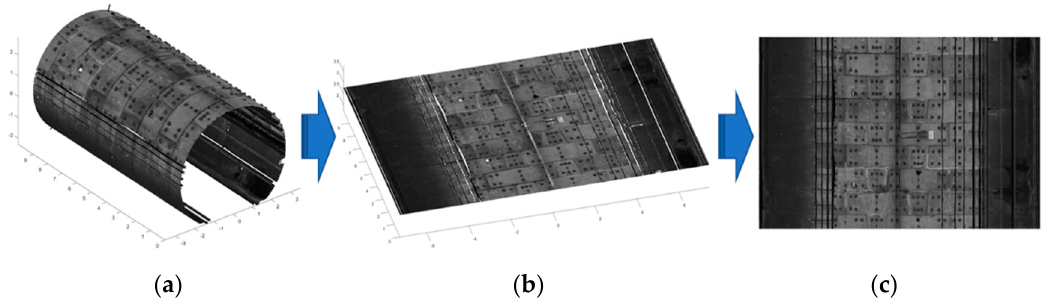
Figure 4. Conversion from 3D point cloud to 2D grayscale image, including: ( a ) 3D point cloud, ( b ) projected 2D point cloud, and ( c ) 2D grayscale image.